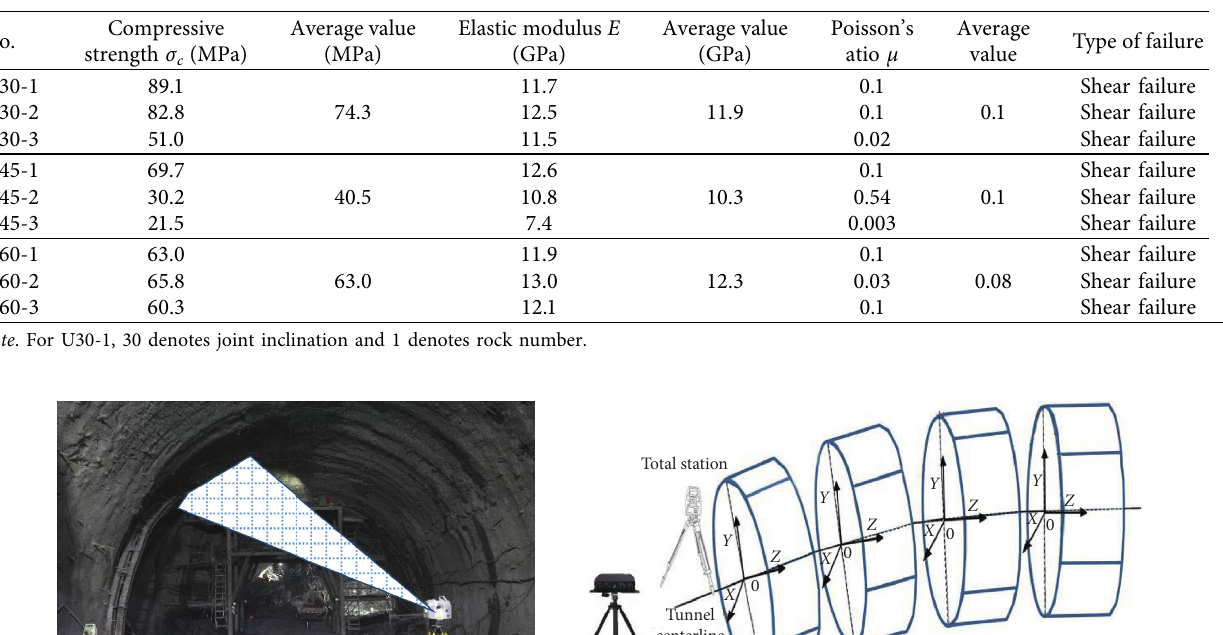
Table 4: Uniaxial compressive strength test results.